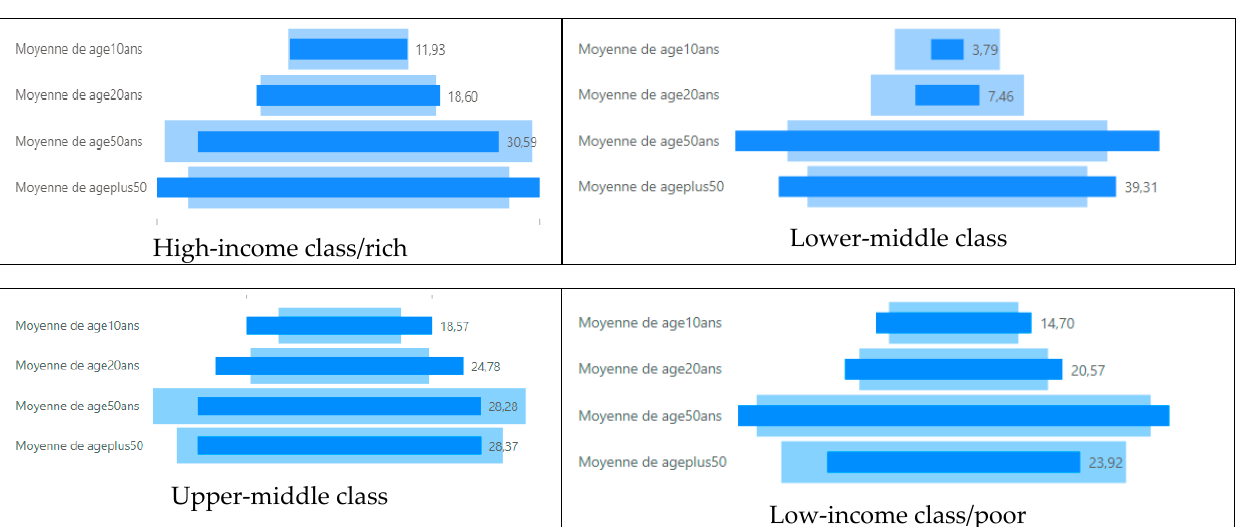
Figure 12. Rate of occupancy by household according to social class.